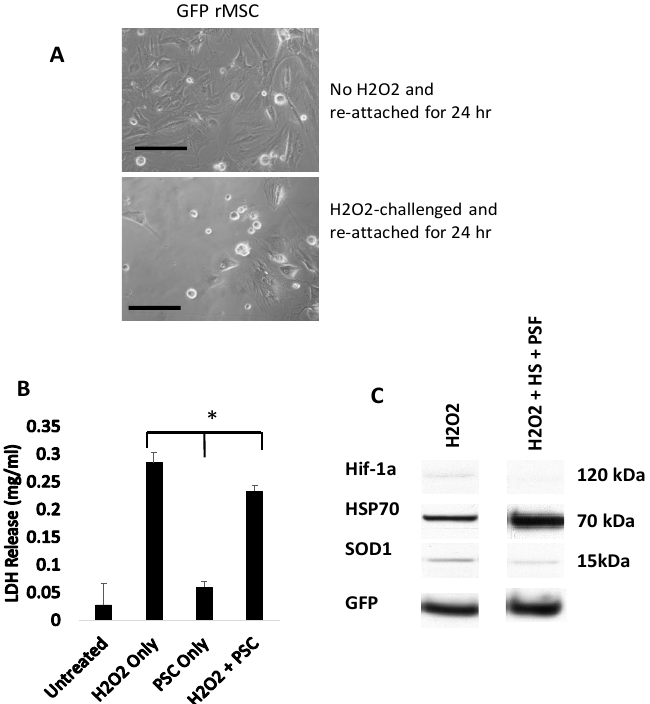
Figure 3. GFP-rMSCs following in vitro stress assays. ( A ) Trypsinized and re-plated GFP-rMSCs at 24 h following hydrogen peroxide treatment. PSF-treated cells were much more abundant and had begun dividing, but GFP-rMSCs not treated with PSF appeared to have lasting negative effects of H 2 O 2 exposure. ( B ) Lactate dehydrogenase released into medium of the hydrogen peroxide-treated cells was a means to measure cell death. ( C ) Changes in expression of stress-related proteins Hif-1a, HSP70, and SOD1 in GFP-rMSCs following hydrogen peroxide treatment. * Indicates p < 0.5. Experiments were repeated twice. Bar =100 µm.